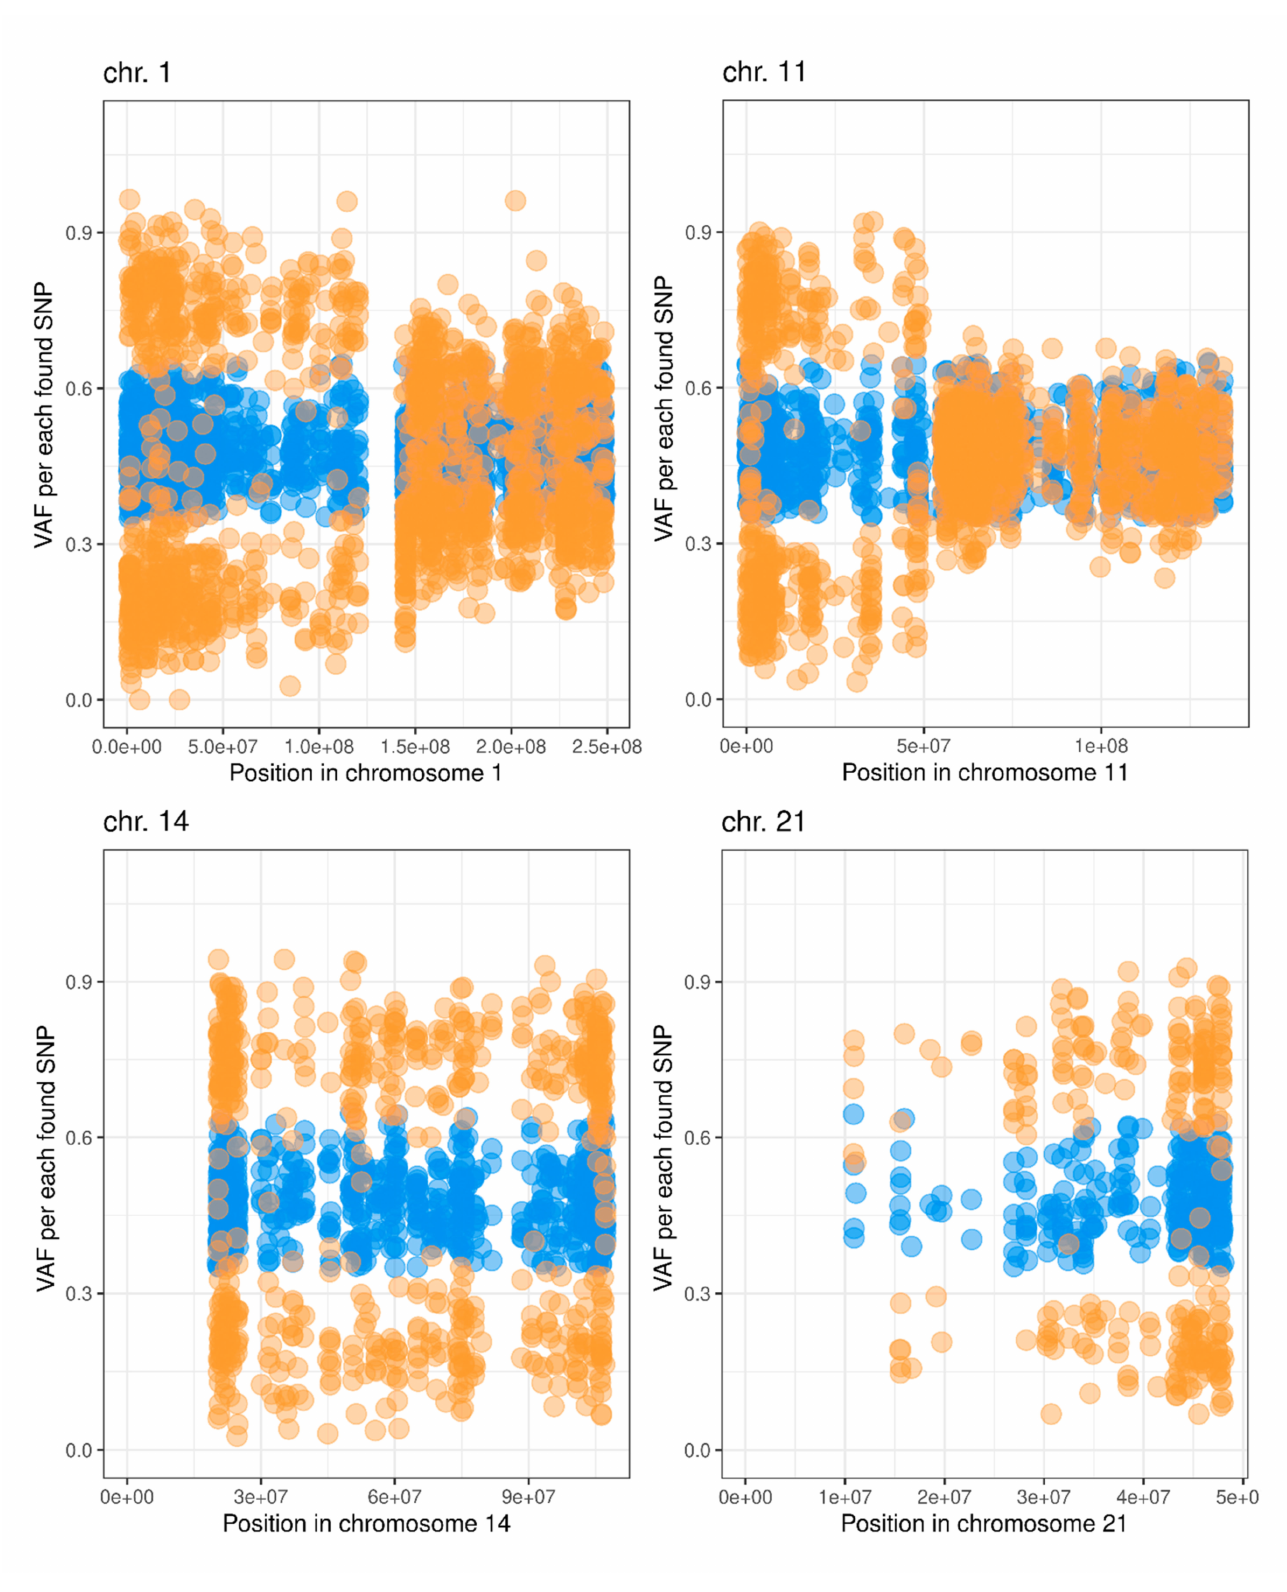
Figure 4. Variant allele frequency (VAF) across chromosome 1, 11, 14, and 21 of recurrent tumor (orange dots) and lymph node (blue dots) in a patient with